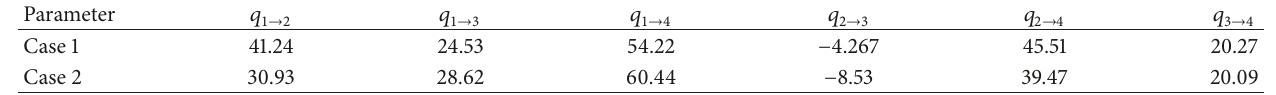
Table 10: Heat flows (W).